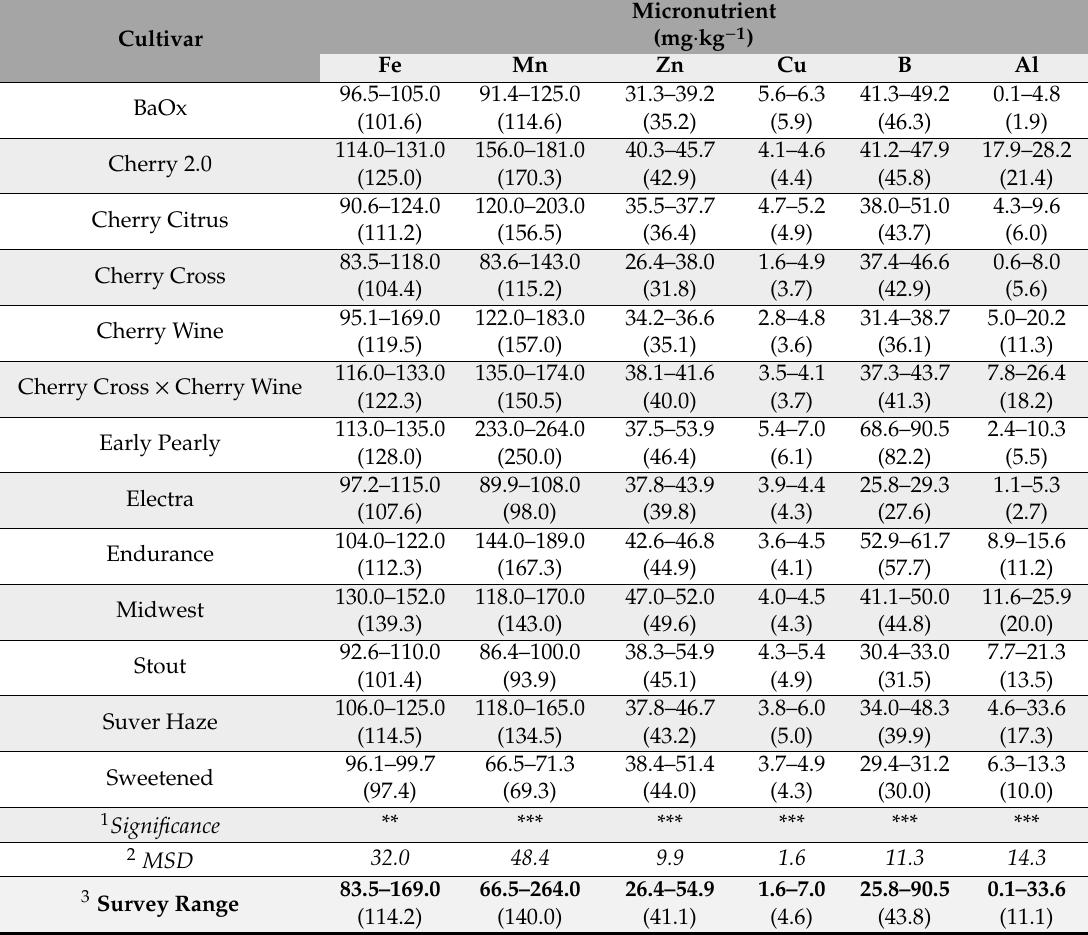
Table3. Leaftissuemicro-nutrientconcentrationrangesforthirteengreenhouse-propagatedcannabidiol (CBD) hemp cultivars. Means are delineated in parenthesis following each cultivar nutrient range. Plants were 12 weeks old and in a vegetative stage of development prior to the excision of initial cuttings for